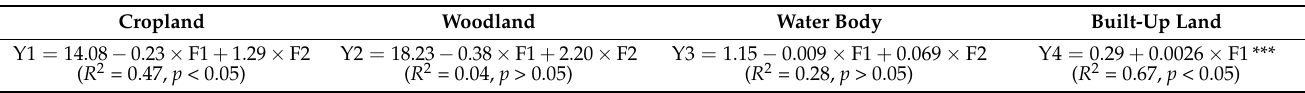
Table 7. Relationships between land cover change and principal components in different types. Cropland Woodland Water